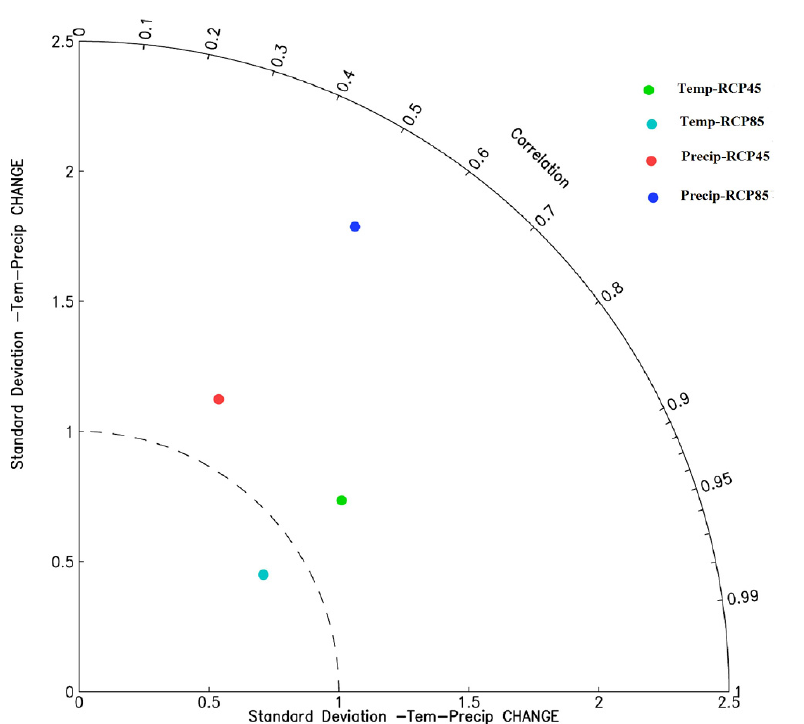
Figure 9. Taylor diagram computed for the change in temperature and precipitation of the period 2070 − 2099 with respect to 1976 − 2005 for RegCM4 simulation compared to its own driving